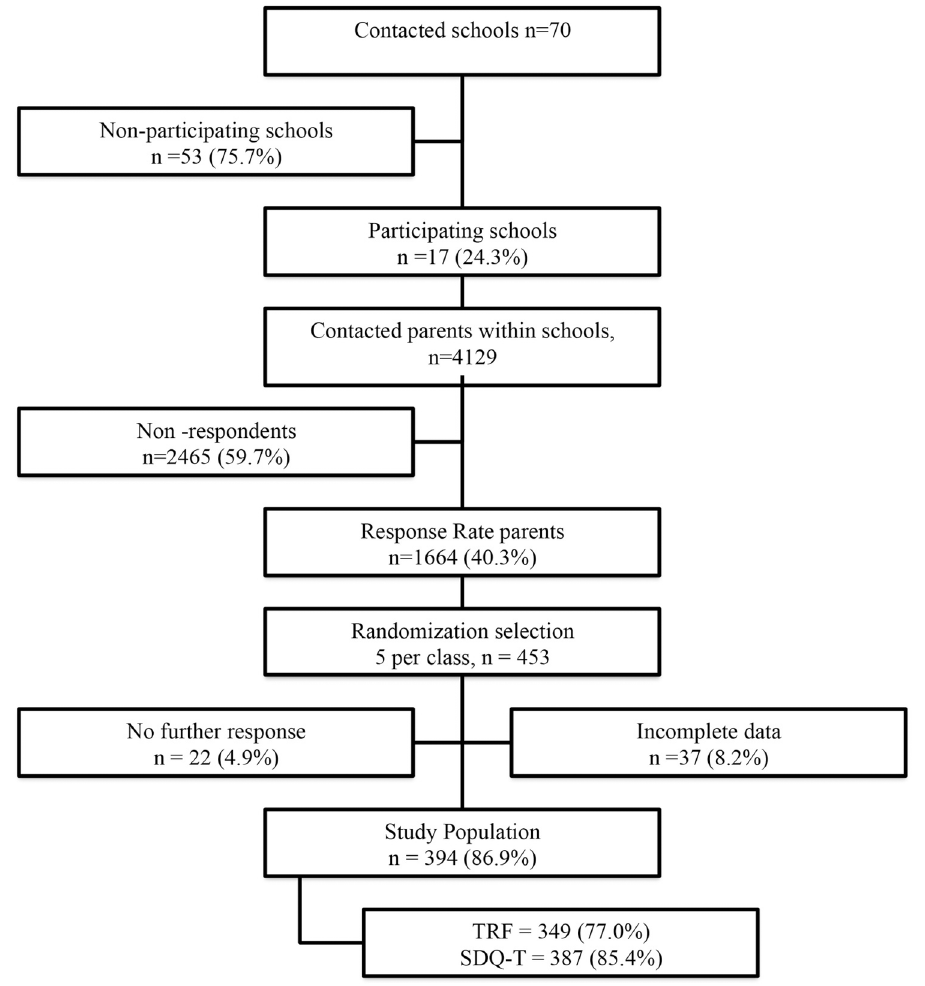
Fig 1. Flow chart for data